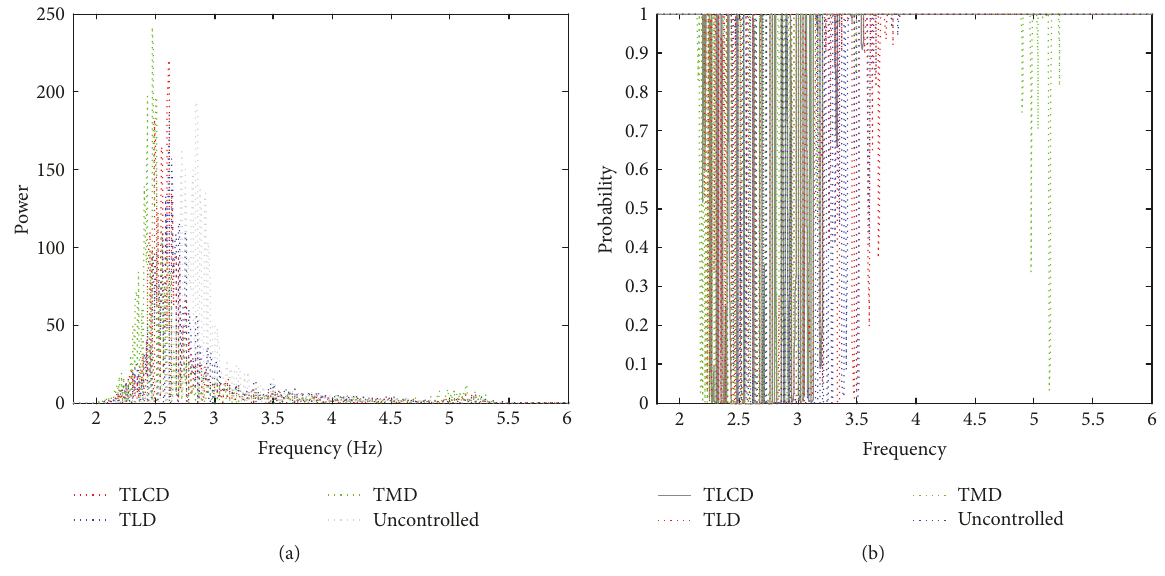
Figure 6: (a) Power spectrum density and (b) probability for the controlling systems. Table 2: WD parameters for the uncontrolled and controlled displacement measurement.